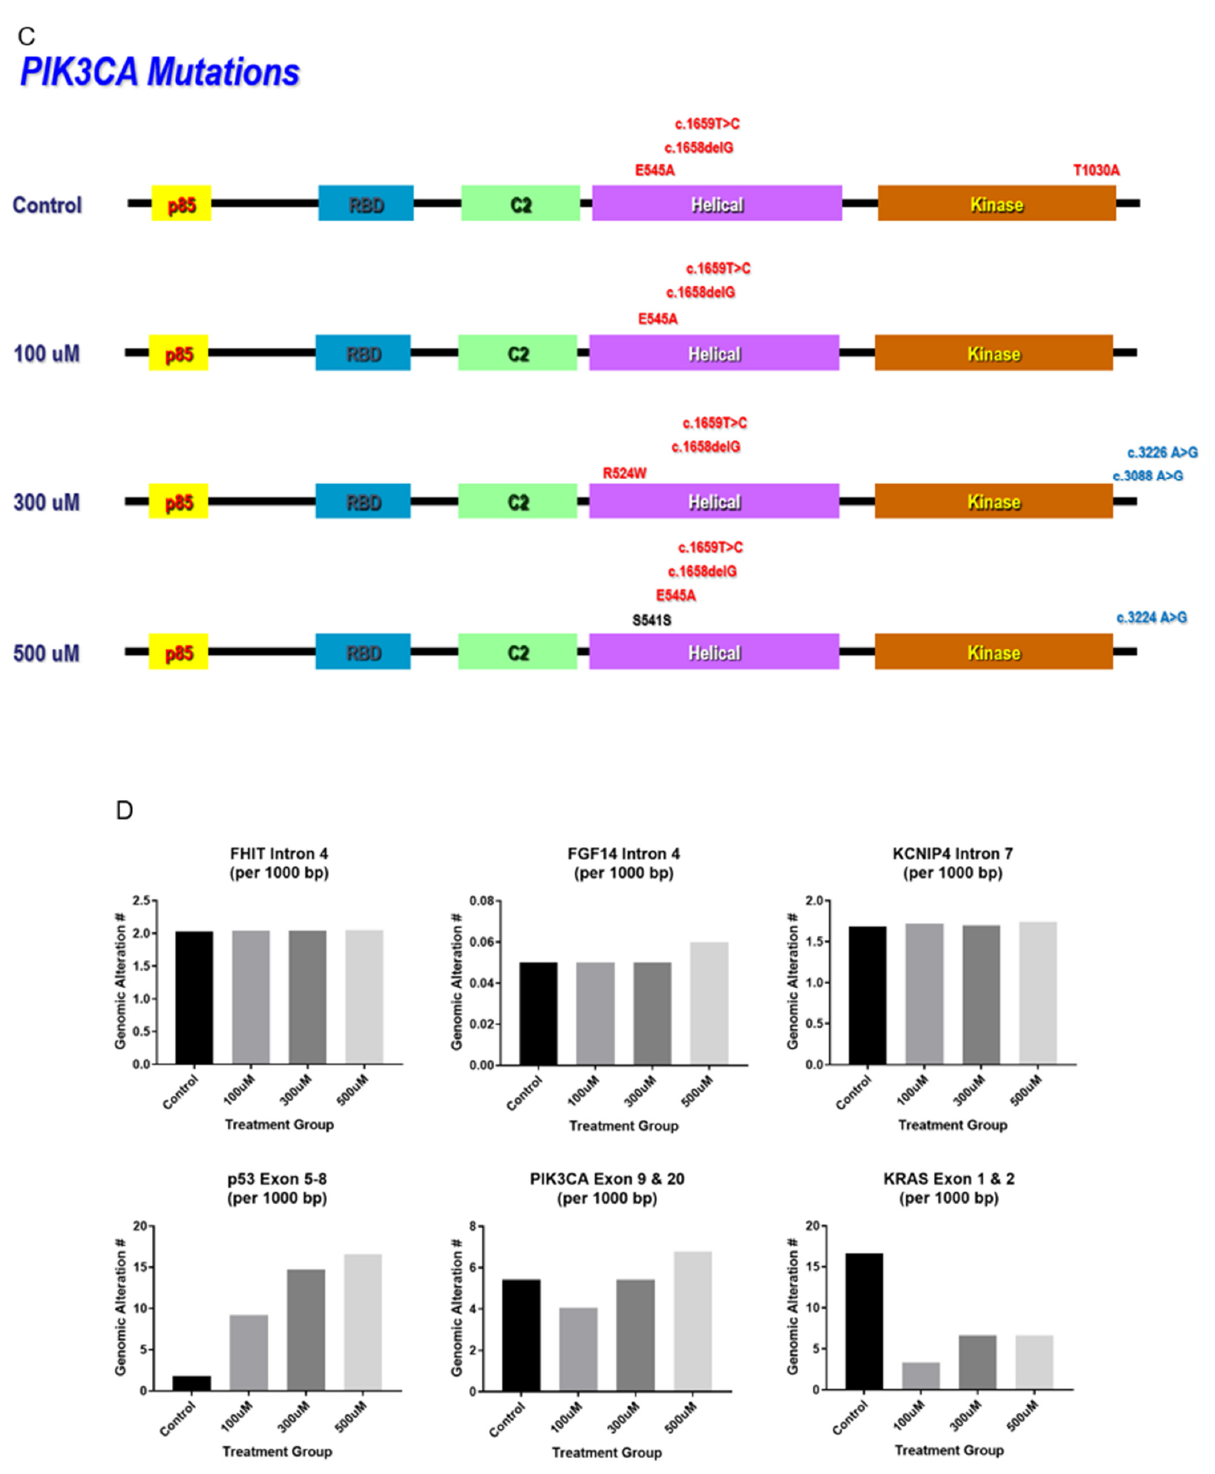
Figure 4. Mutation Hot Spots in TP53, KRAS and PIK3CA genes. Schematic diagrams of ( A ) TP53 (exons 5–8), ( B ) KRAS (exons 1 & 2, indicated with an asterisk), and ( C ) PIK3CA (exon 9 & 20) gene mutation hot spots. Specific mutations identified are shown on top of the gene for different treatment groups. Reported mutations are shown in black font; new mutations are shown in red font, substitution mutation in blue font. ( D ) Mutation Frequency Assessment. The bar charts represent trends of the total number of mutations per 1000 bp, hence no error-bar or statistical significance were